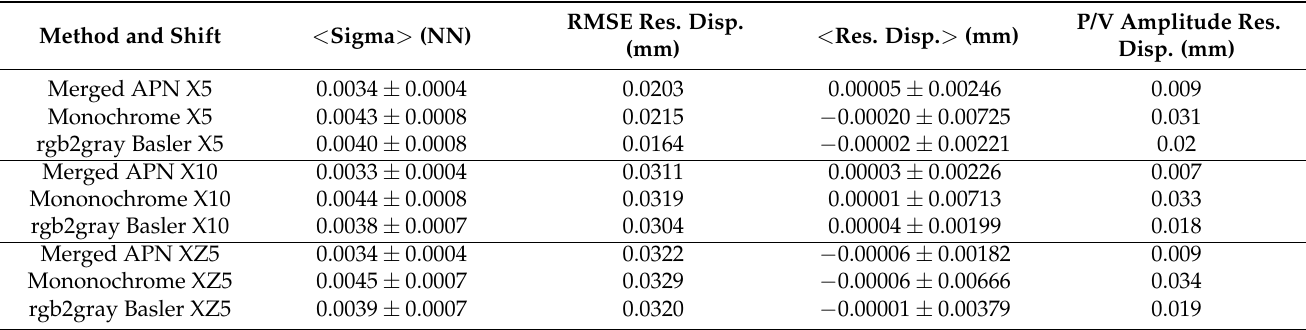
Table 2. Demosaicking evaluation for Mock-up .